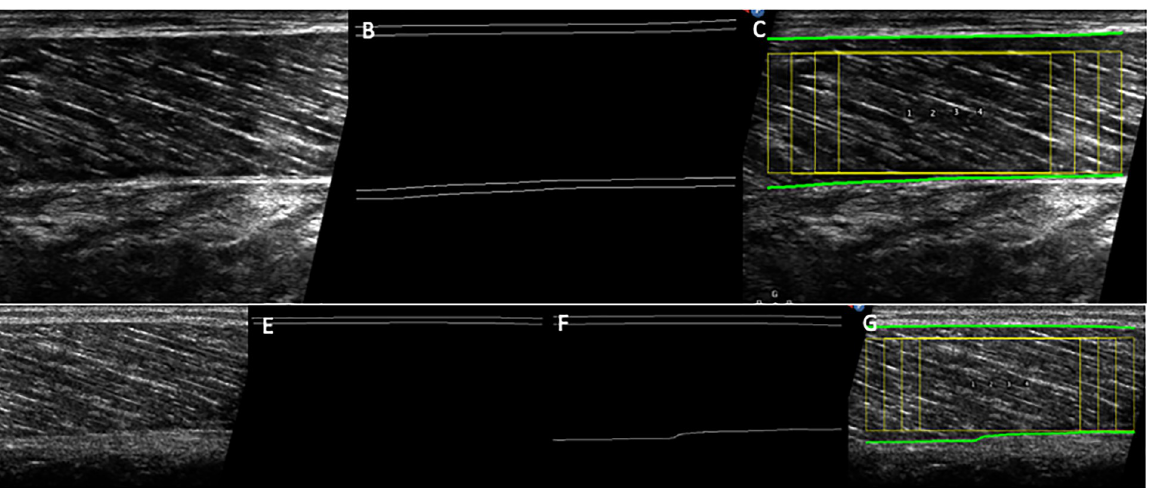
PLOS ONE | https://doi.org/10.1371/journal.pone.0229034 February 12,